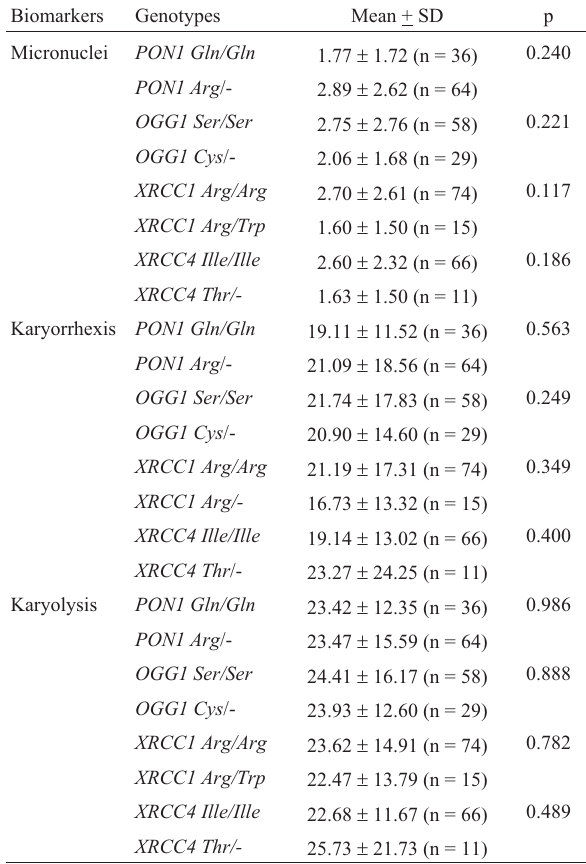
Table 6 - Effects of individual genotypes for metabolism ( PON1 Gln192Arg ) and DNA repair genes ( OGG1 Ser326Cys , XRCC1 Arg194Trp , XRCC4 Ile 401Thr ) polymorphism on the frequencies of the biomarkers evaluated (micronuclei, karyorrhexis and karyolysis) in the exposed groups (mean (cid:2) S.D).